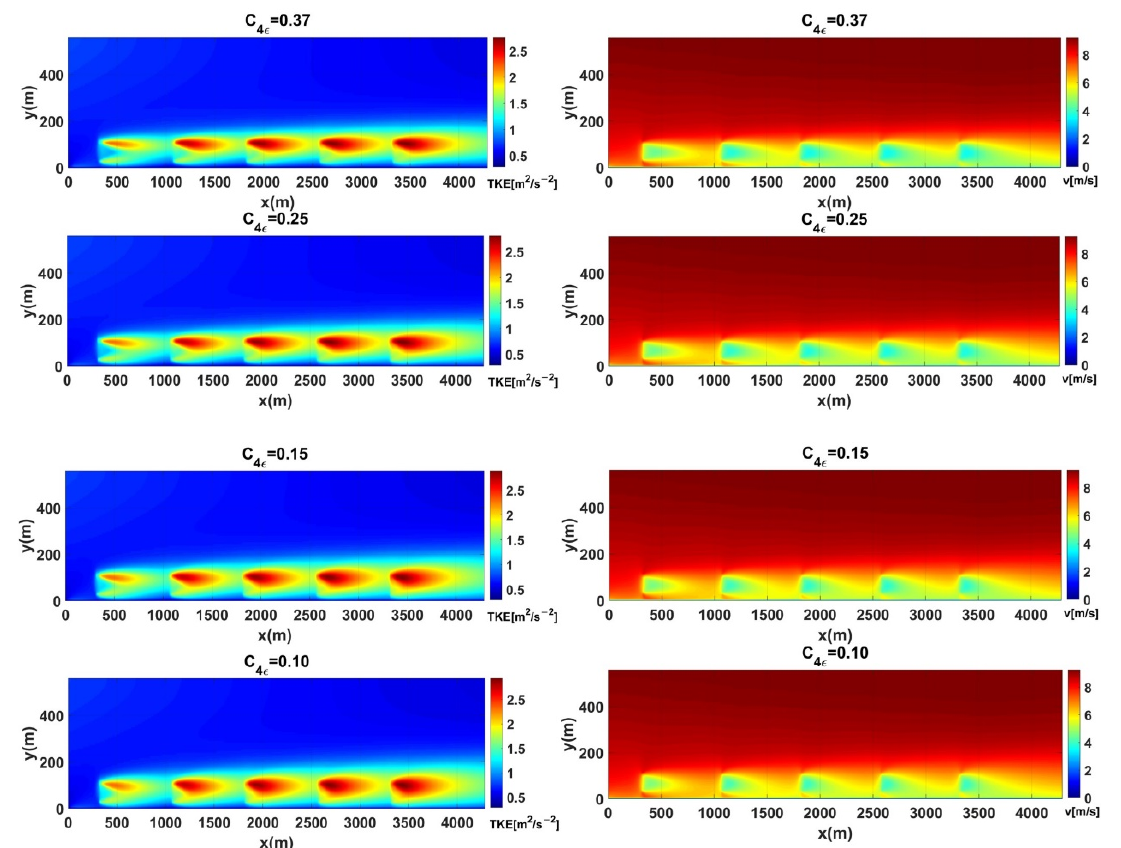
Figure 13. Comparison of contours involving TKE and streamwise wind speed for different C 4 ε in the vertical direction when the incoming wind direction is 222°.